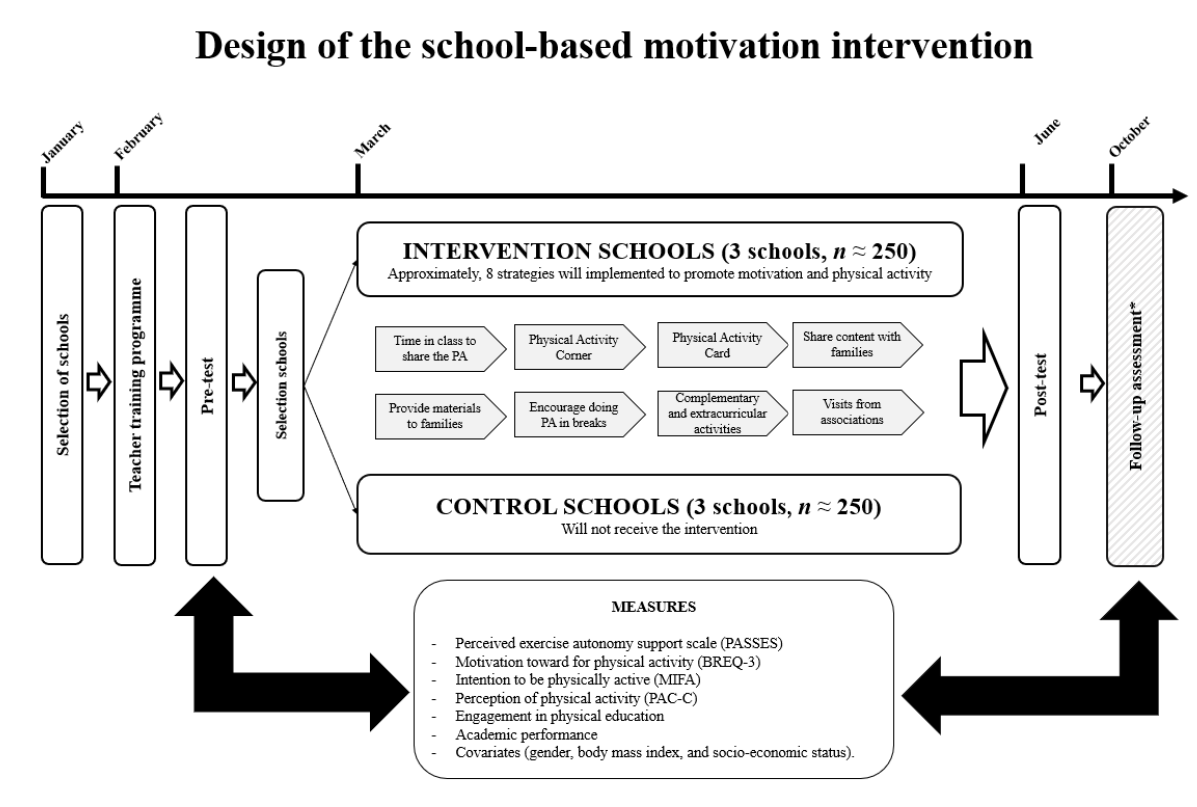
Figure 1. Timeline for data collection in months and schematic overview of study design.